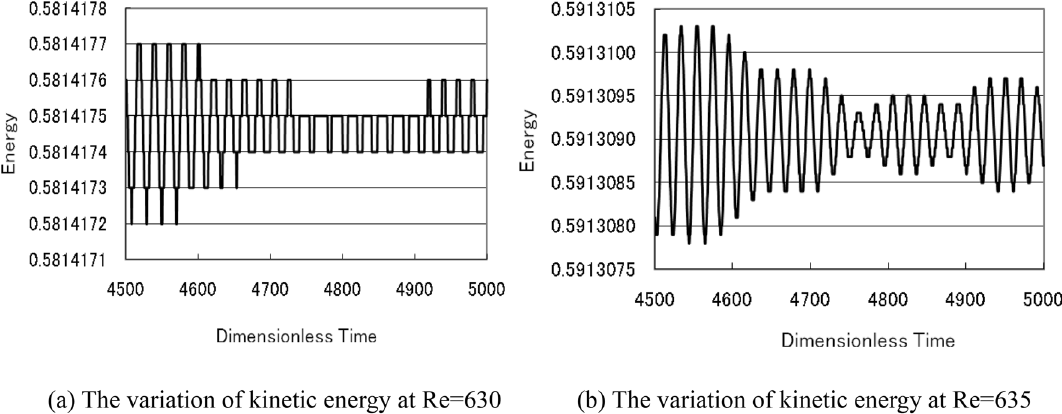
Fig. 2 Analytical results utilizing the kinetic energy at Γ = 3.8. The unit of the energy value is the dimensionless spatial average